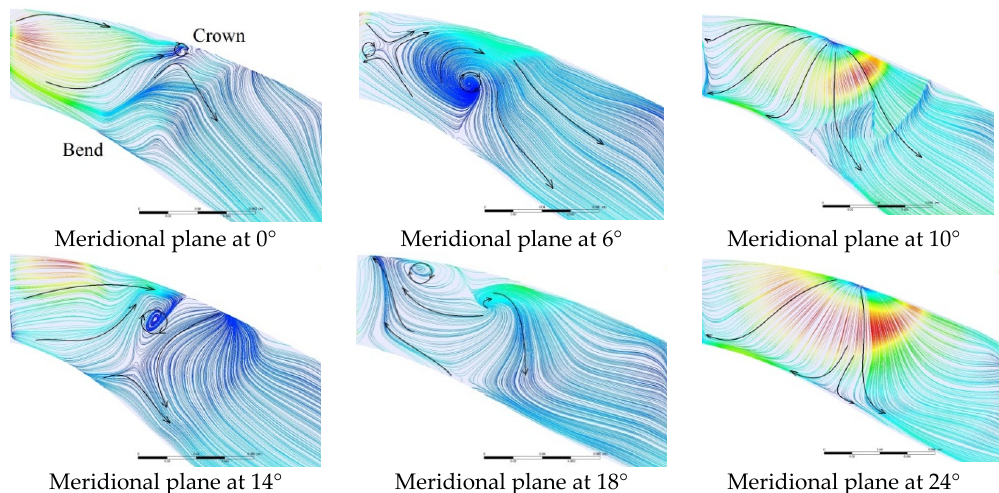
Figure 17. Flow field for the meridional planes of the runner at the instant t = 1.1442 s; the planes at 0, 10, 14 and 24° indicate the suction side of the blade, the pressure side of the splitter, the suction side of the splitter and the pressure side of the next blade, respectively; the planes at 6 and 18° indicate the middle of the two blade channels; bold arrows indicate the flow direction from/to the swirling regions; the color scales of the streamlines are similar to those used in Figure 15 in the rotating frame of reference.